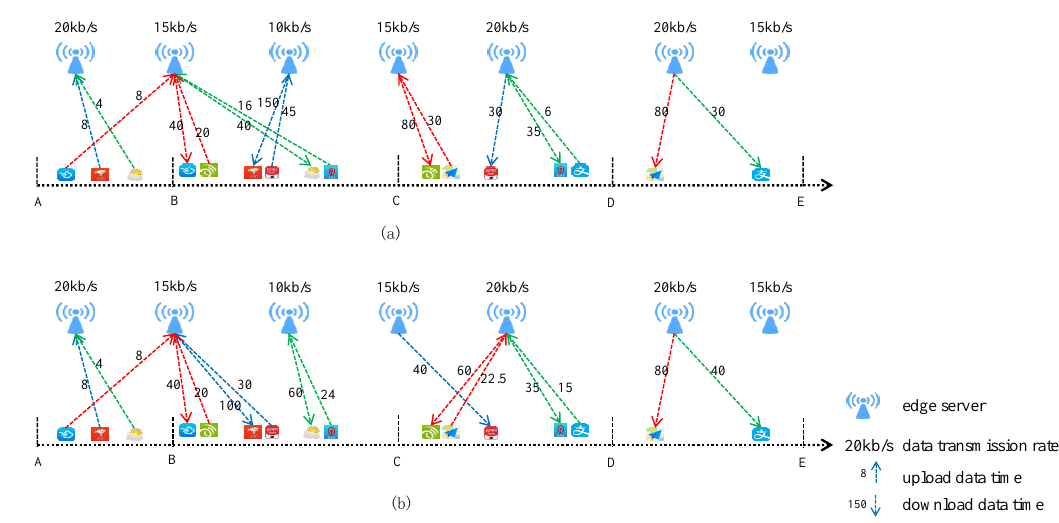
Figure 3. The examples of multi-user edge server selection with service composition in